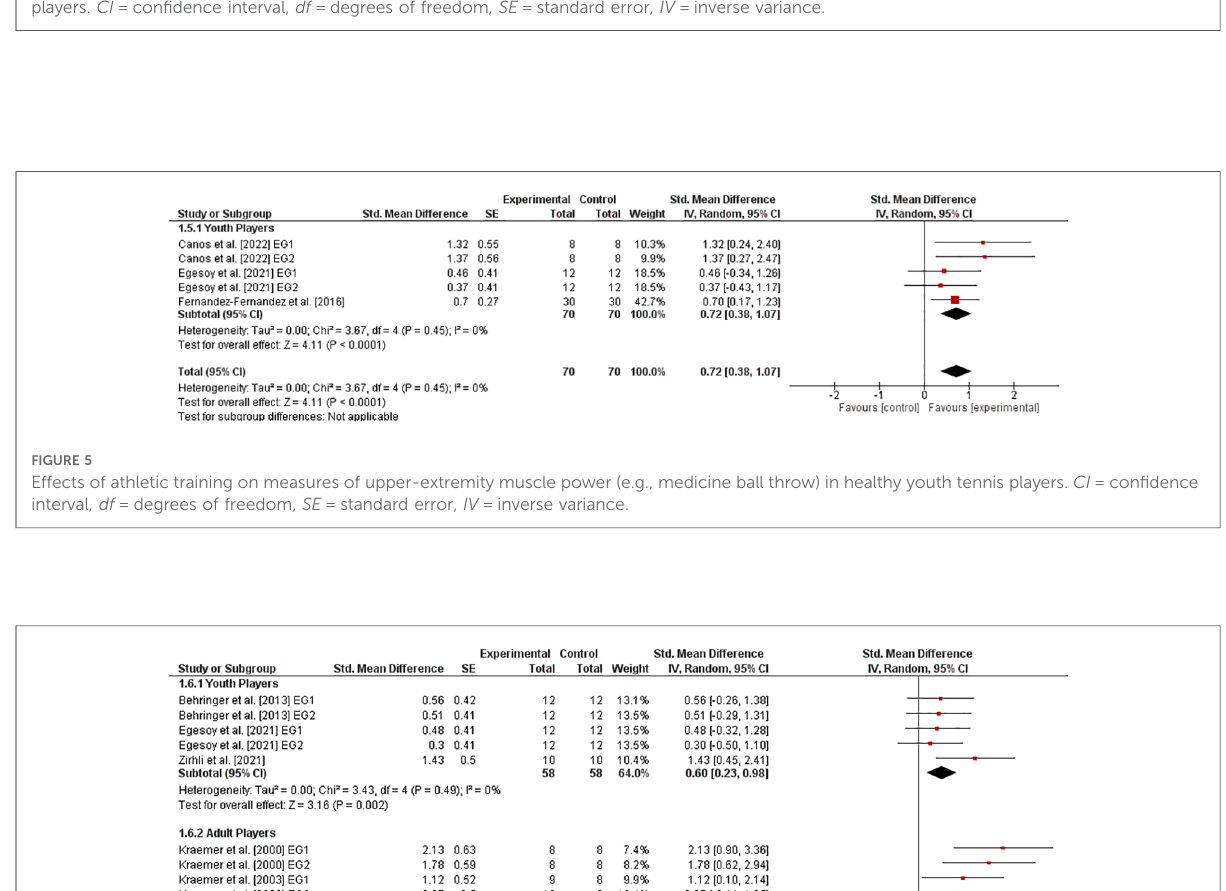
FIGURE 4 Effects of athletic training on measures of lower-extremity muscle power (e.g., counter movement jump height) in healthy youth and adult tennis players. CI =con fi dence interval, df =degrees of freedom, SE =standard error, IV =inverse variance.